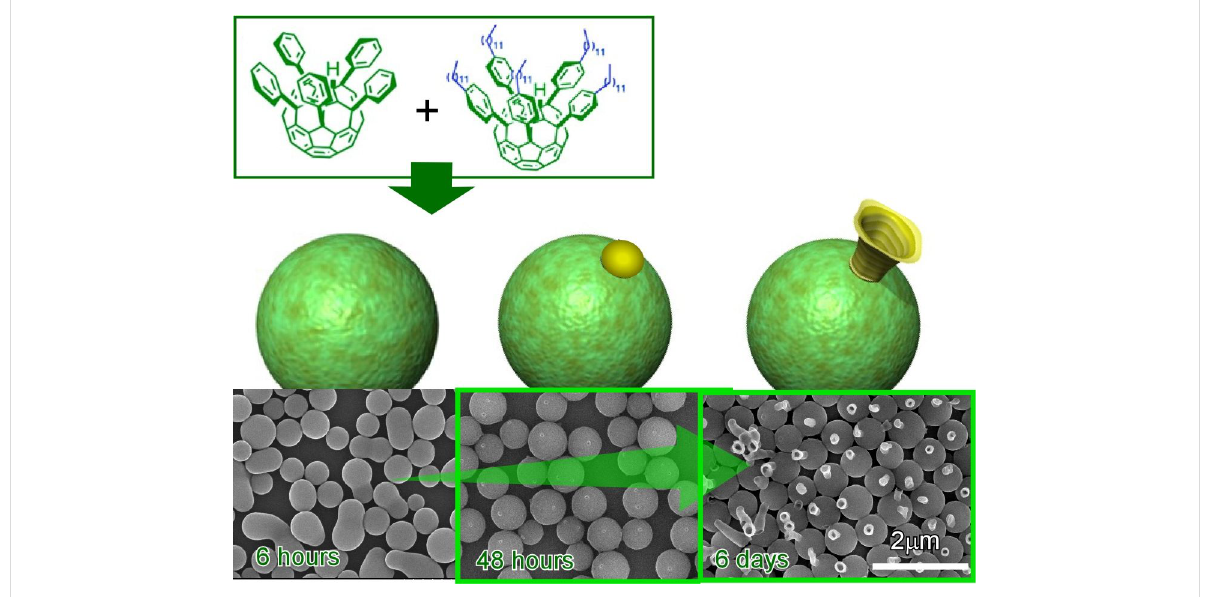
Figure 23: Time-dependent shape shift of co-assemblies of two fullerene derivatives, pentakis(phenyl)fullerene and pentakis(4-dodecylphenyl)fuller- ene from egg-like structures to tadpole-like structure regarded as supramolecular differentiation. Reproduced from [75], copyright 2019 The Authors.